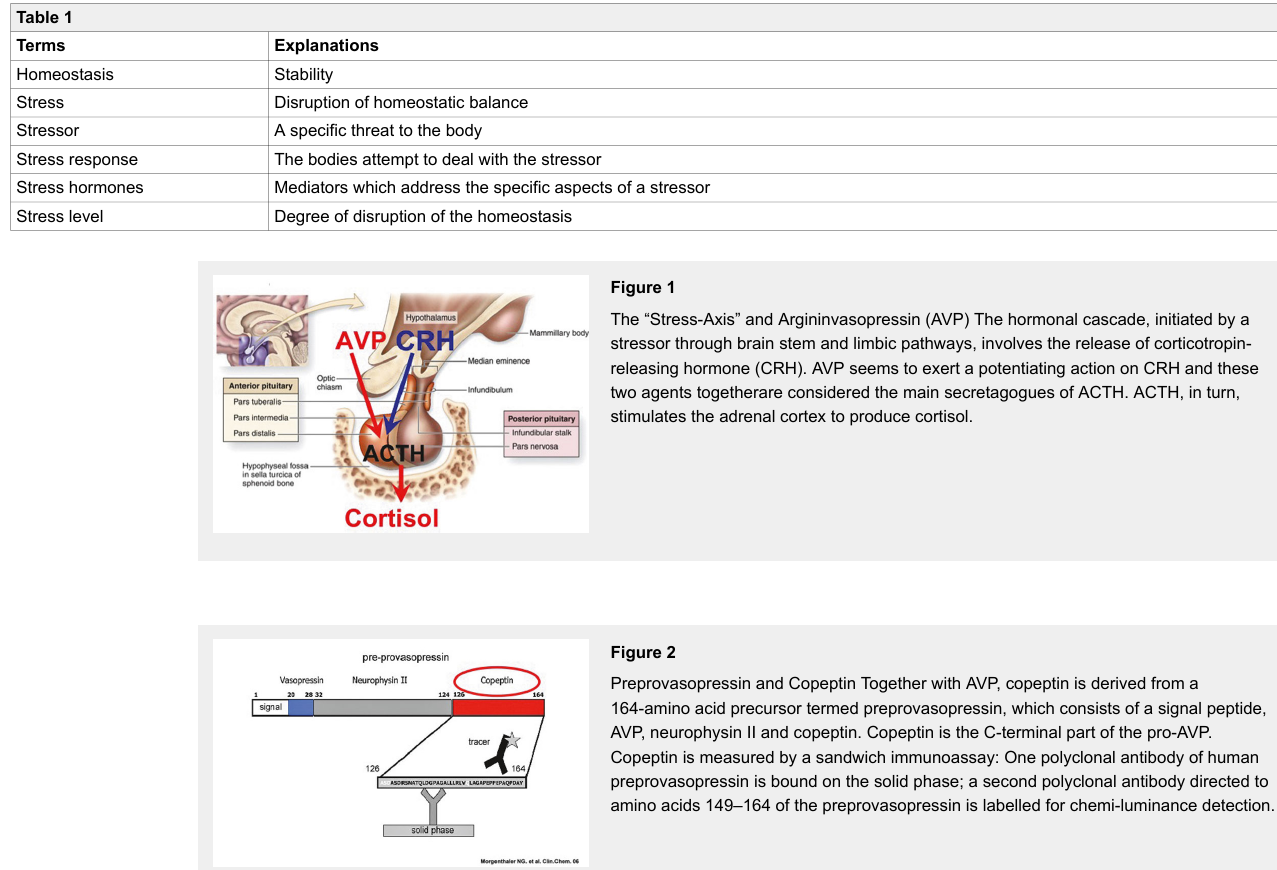
The “Stress-Axis” and Argininvasopressin (AVP) The hormonal cascade, initiated by a stressor through brain stem and limbic pathways, involves the release of corticotropin- releasing hormone (CRH). AVP seems to exert a potentiating action on CRH and these two agents togetherare considered the main secretagogues of ACTH. ACTH, in turn, stimulates the adrenal cortex to produce cortisol.